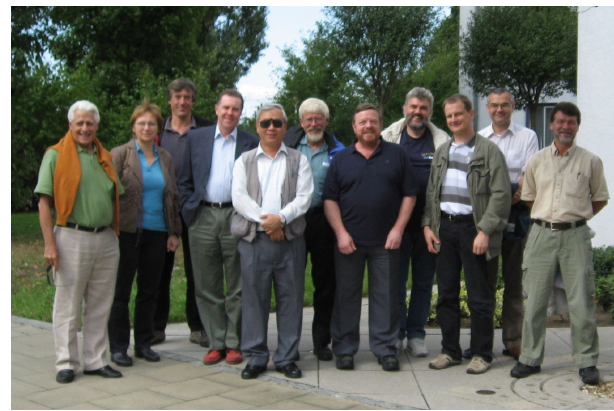
Figure 9. Members of WG 127 (source: Fig. 10 in Millero,